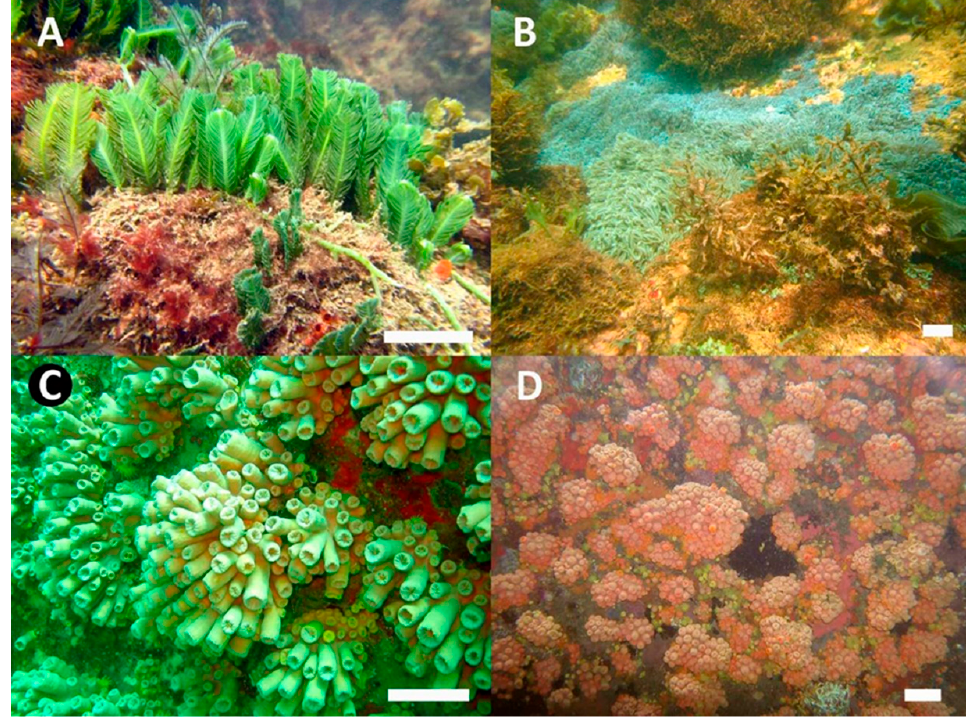
Figure 2. Alien species studied in the present work: ( a ) Caulerpa scalpelliformis ; ( b ) Sansibia sp.; ( c ) Tubastraea tagusensis ; ( d ) Tubastraea coccinea .